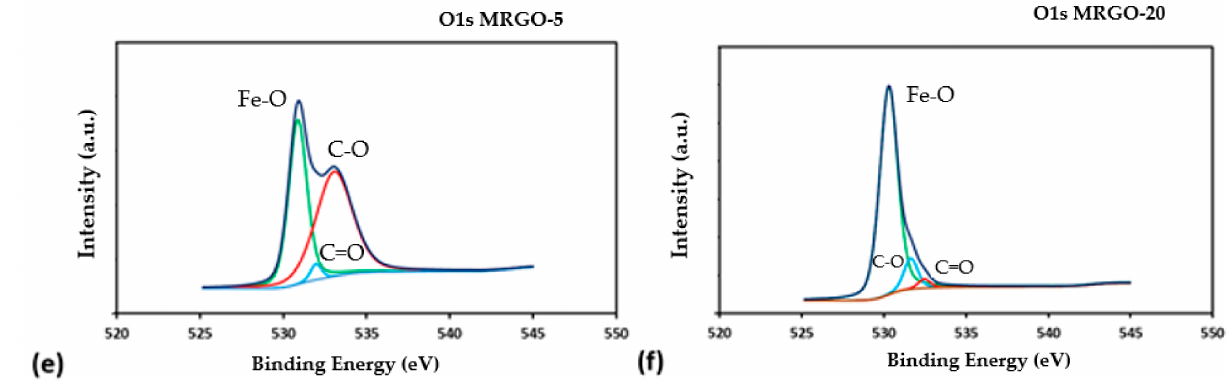
Figure 7. XPS analysis of ( a ) wide scan of MRGO-5 and MRGO-20, ( b ) Fe2p scan of MRGO-5 and MRGO-20, ( c ) C1s scan of MRGO-5, ( d ) C1s scan of MRGO-20, ( e ) O1s scan of MRGO-5 and ( f ) O1s scan of MRGO-20.